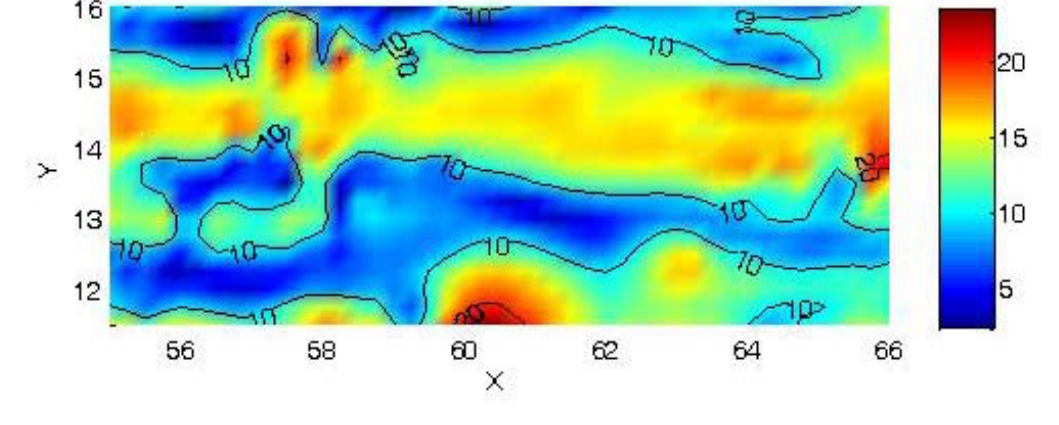
Figure 4. Magnetic anomalies in the first sector with precise geometry. Units in